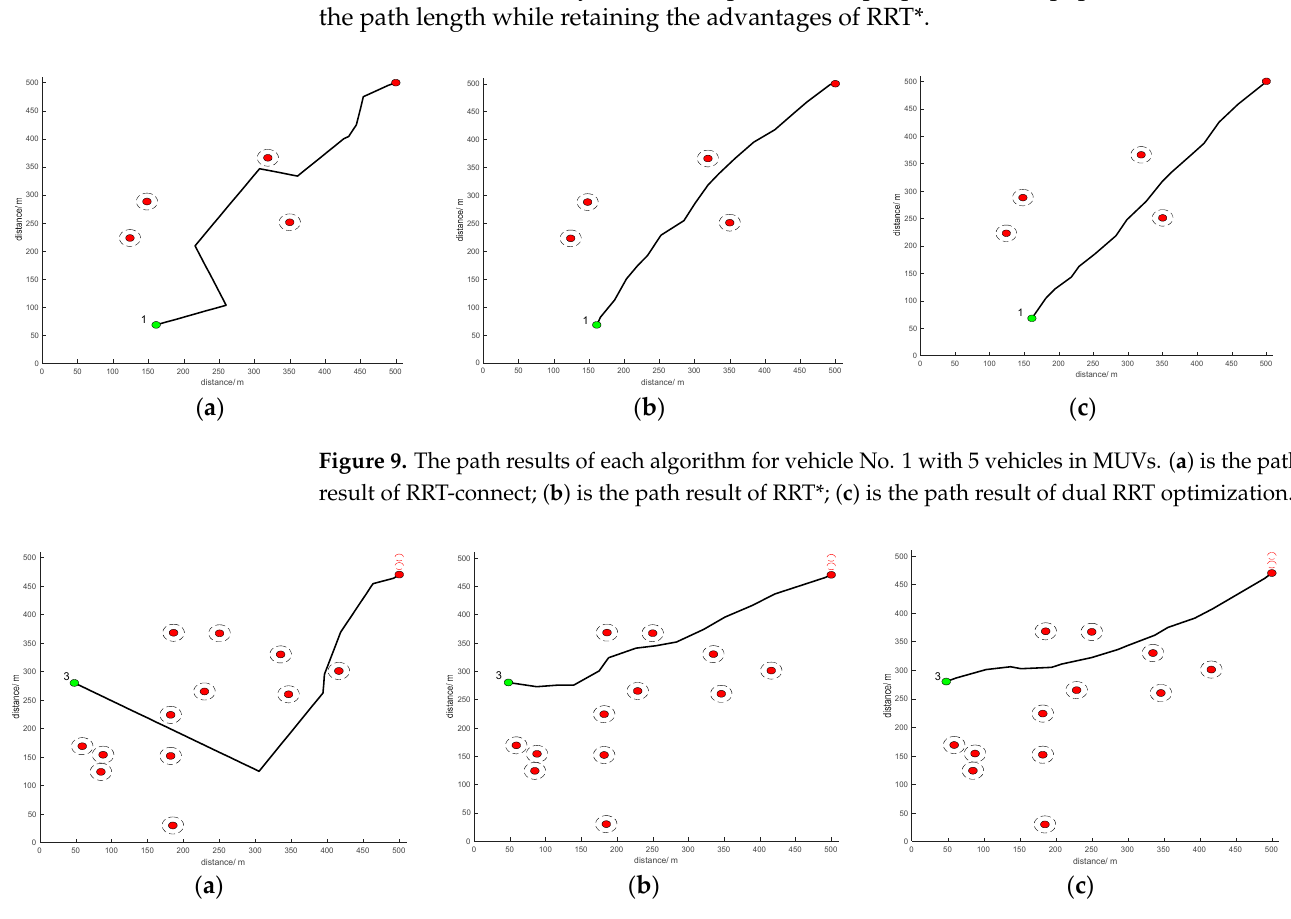
Figure 10. The path results of each algorithm for vehicle No. 3 with 15 vehicles in MUVs. ( a ) is the path result of RRT-connect; ( b ) is the path result of RRT*; ( c ) is the path result of dual RRT optimization.